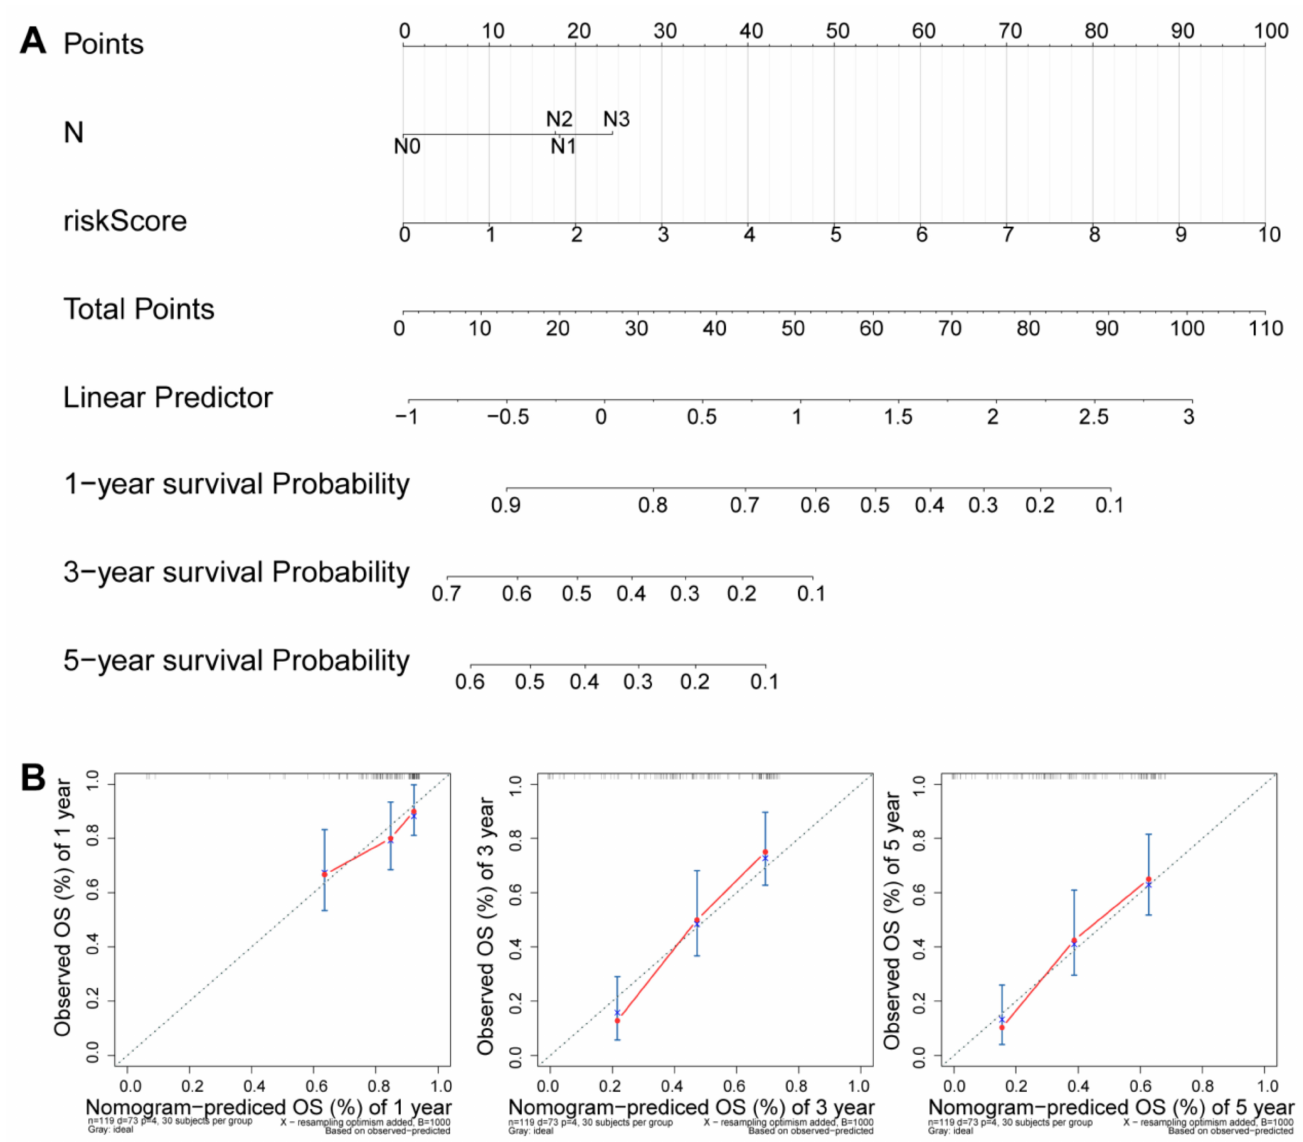
Figure 6. Establishment of a nomogram for survival prediction in GSE53624; ( A ) Nomogram model consisting of N stage and risk score factors for 1-, 3-, and 5-year OS prediction; ( B ) Calibration curves of the nomogram model showing the predicted survival probabilities and the actual ob- served